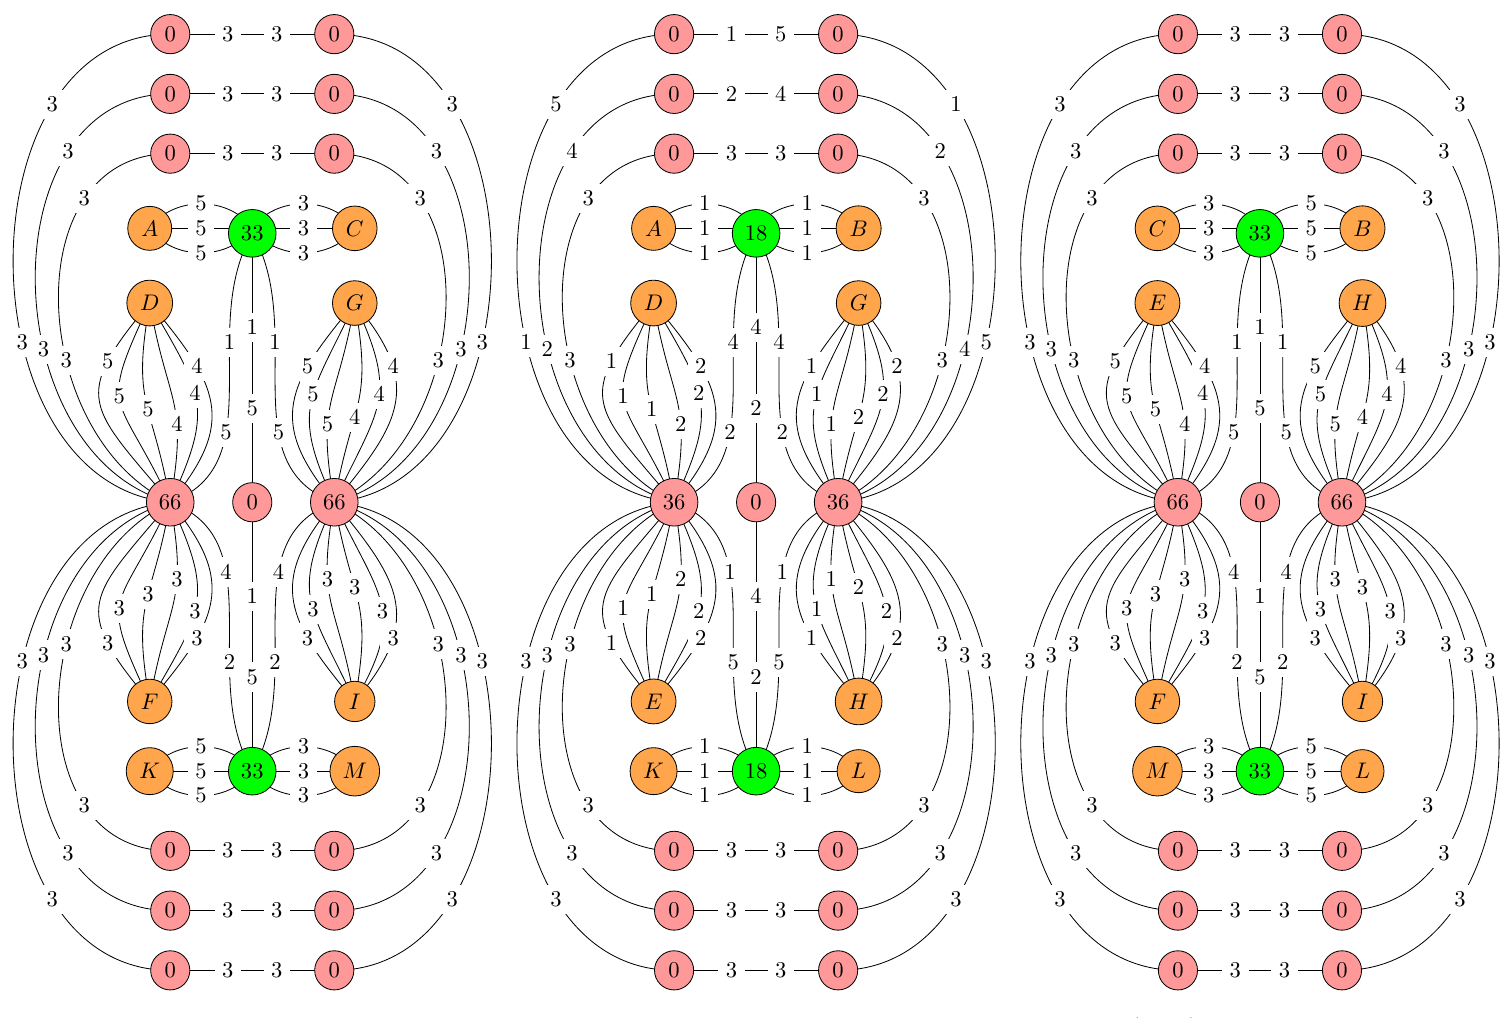
Figure 2 . Weighted diagram of roots P •